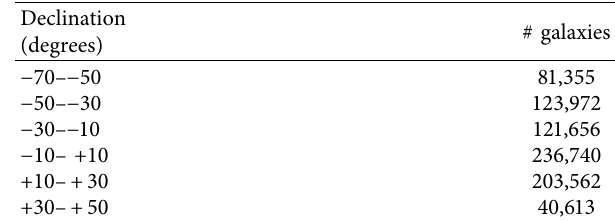
Table 2: The number of DECam galaxies in different declination ranges.